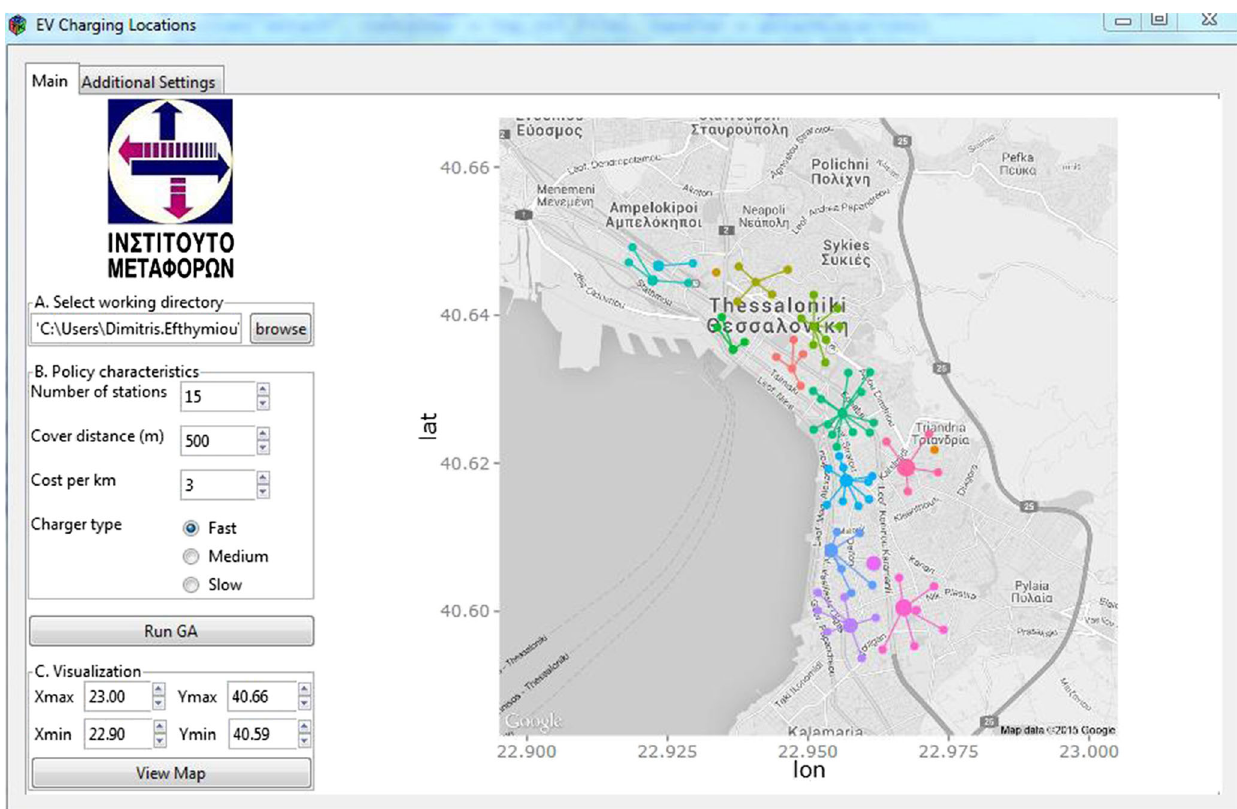
Fig. 3 Electric Vehicle Charging Locations Optimization Tool (developed in